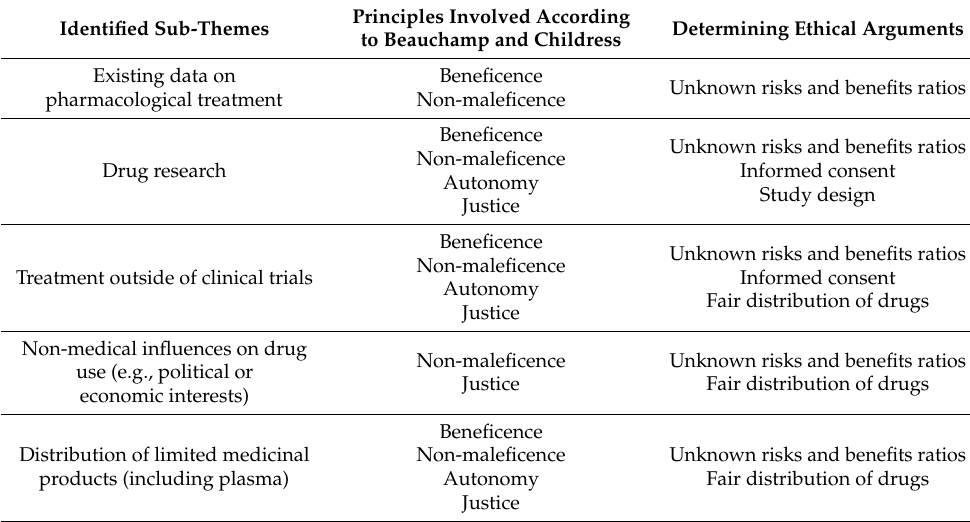
Table 1. Determining ethical arguments within the five identified